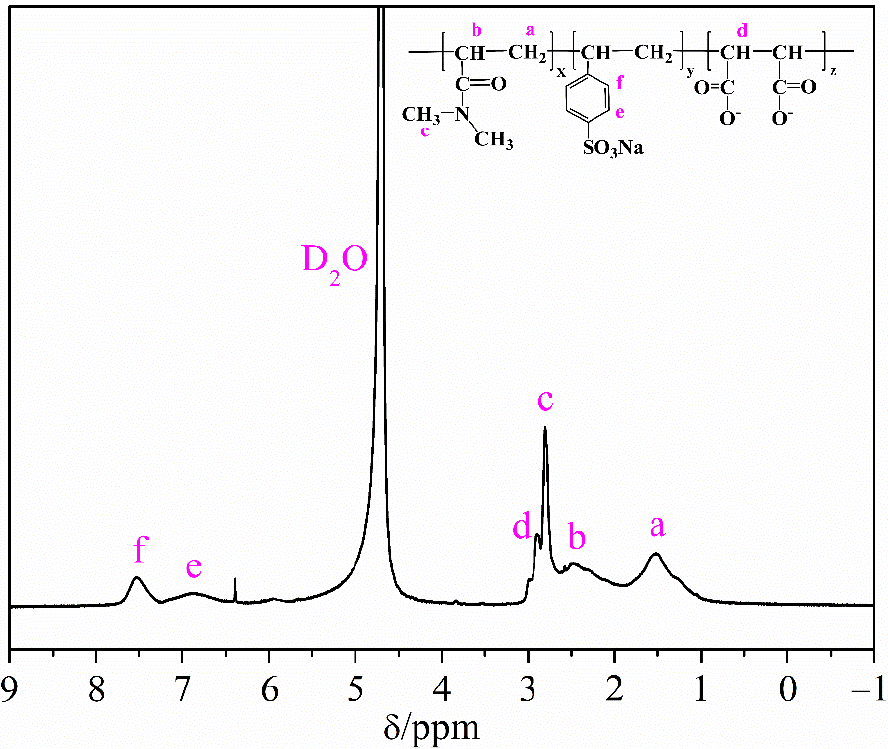
Figure 2. 1 H NMR curves of LDMS, (a–f represent hydrogen elements at different positions in the molecular chain).